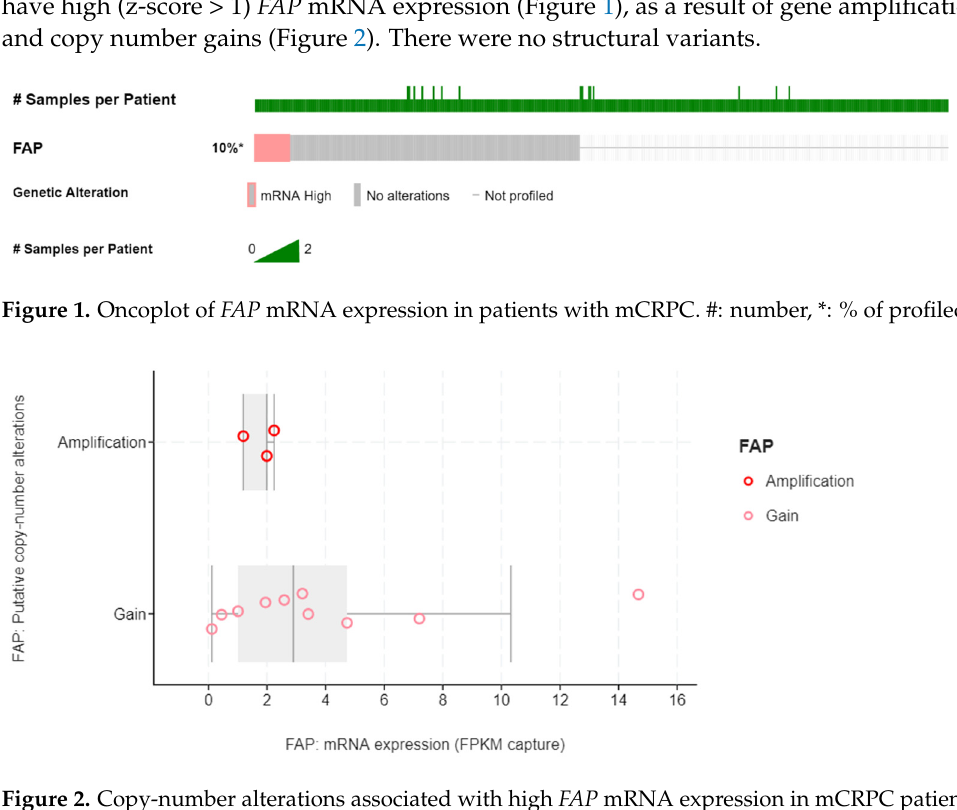
Figure 2. Copy-number alterations associated with high FAP mRNA expression in mCRPC